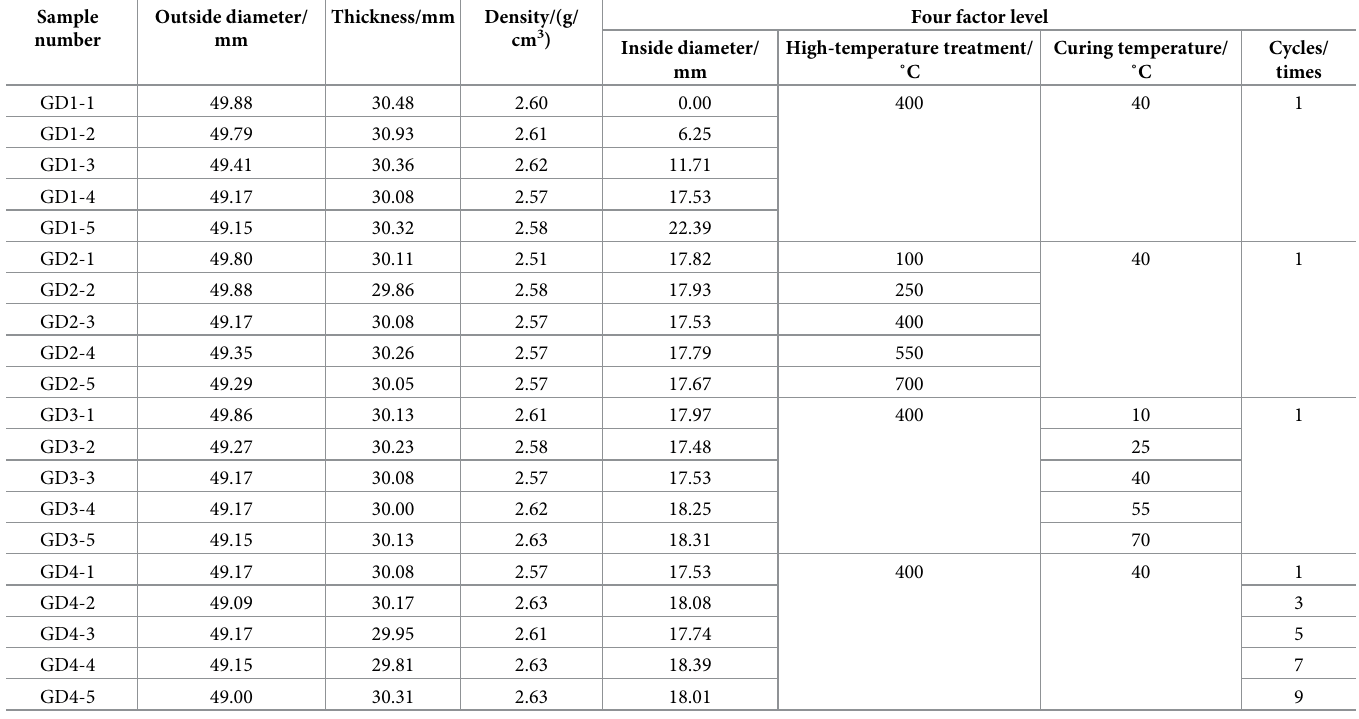
Table 1. Radial impact test scheme of circular granite under the condition of the heat treatment and water curing. Sample Outside diameter/ number